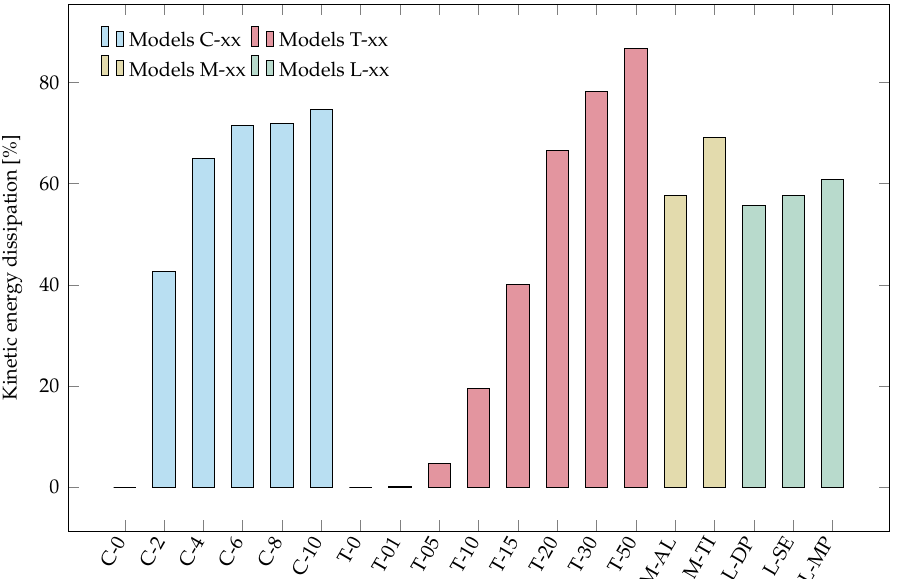
Figure 12. Kinetic energy dissipation for the honeycomb core density, shell thickness, material and impact location models, relative to reference cases (see Table